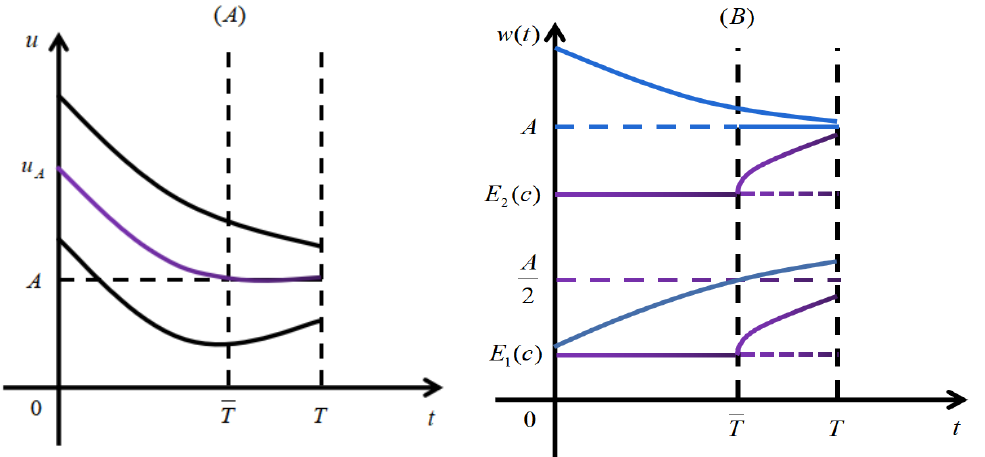
Figure 1. ( A ): There exists a unique u A for the model (3) and (4) such that the solution w ( t ) is strictly decreasing for t ∈ [ 0, T ] when u > u A ; ( B ): When 0 < c < g ∗ , the movement trend of the solution of the model (3) and (4) for t ∈ [ 0, T ] and u ∈ [ E 1 ( c ) , E 2 ( c )]